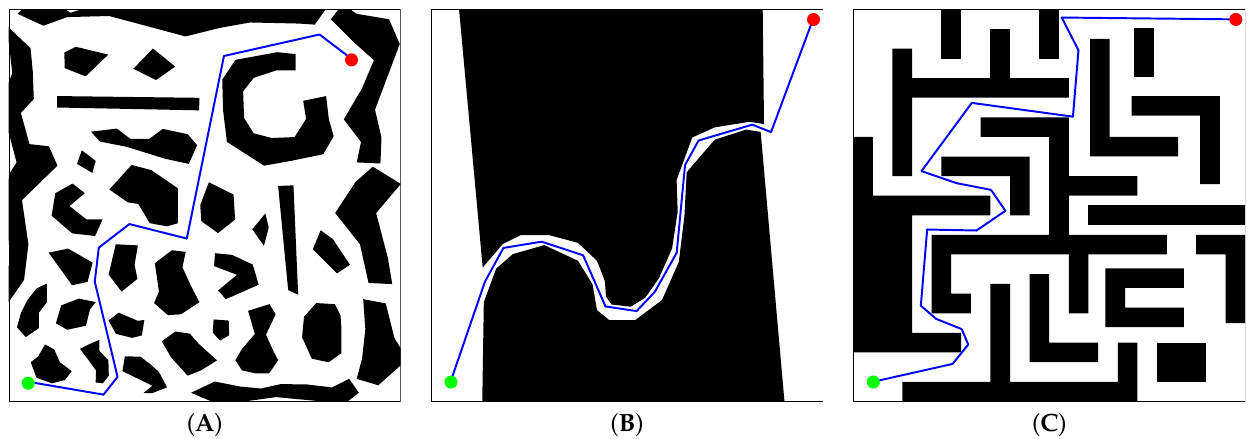
Figure 7. Paths achieved by RRT*-Smart for test cases ( A – C ),